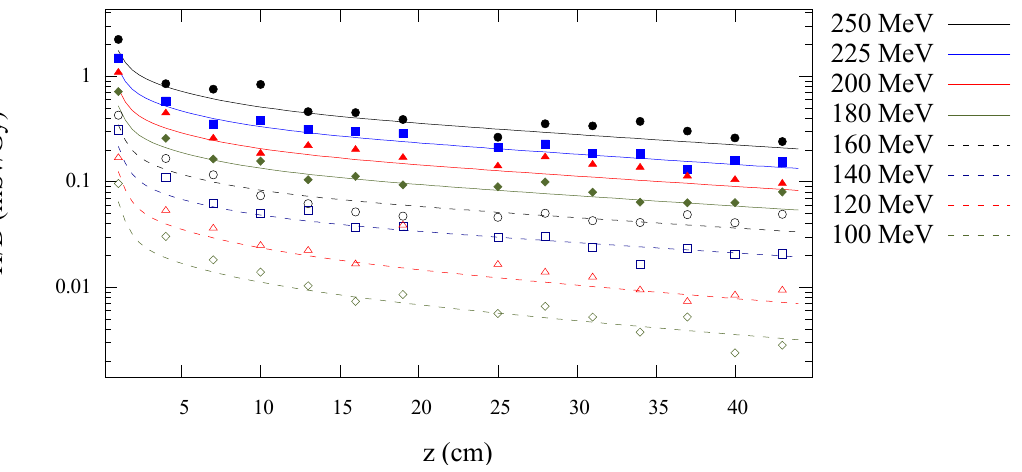
Figure 7. Predictions from Monte Carlo (points) and analytical model (lines) of neutron equivalent dose per treatment dose (𝐻/𝐷) versus depth in water at 80 cm off-axis for 100 to 250 MeV proton beam energies.